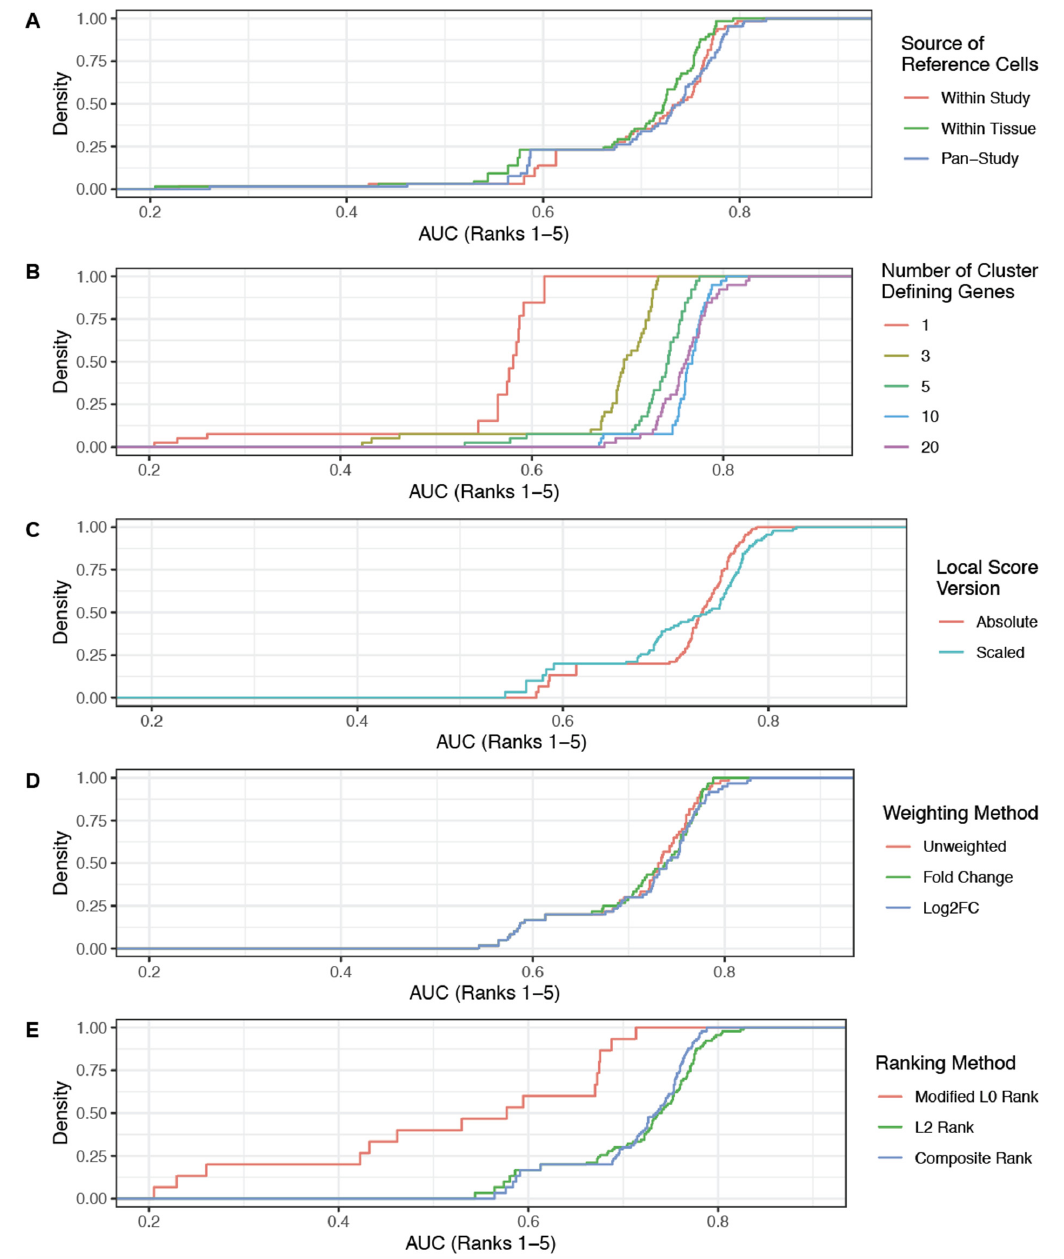
Figure 5. Effects of altering individual parameters on cluster annotation algorithm. Plots shown are the cumulative distribution functions of the AUC Ranks 1–5 metric. Each panel illustrates the effect of modifying a single parameter on the algorithm performance. ( A ) Modifying the source of reference cells used to compute CDGs for downstream analysis has a limited impact on performance, with the pan-study and within study options slightly outperforming the within tissue option. ( B ) Modifying the number of CDGs considered has a strong impact on performance, with fewer genes (e.g., 1, 3, or 5) showing considerably worse performance. ( C ) Modifying the local score version used (absolute or scaled) has a mixed effect, with scaled GCAs contributing more of the worst-performing (left tail) and best-performing (right tailed) parameter combinations. Note that only the parameter combinations which used an L2 norm-based rank or the composite rank were included in this analysis, as only absolute GCAs were considered for the modified L0 norm-based ranking. ( D ) Modifying the weighting method for calculating the L2 norm has minimal impact on performance, with weighting by either fold change (FC) or log 2 FC slightly outperforming the unweighted method. ( E ) Modifying the final ranking method has a strong impact on performance, with the modified L0 rank and L2-based rank showing the worst and best performances,